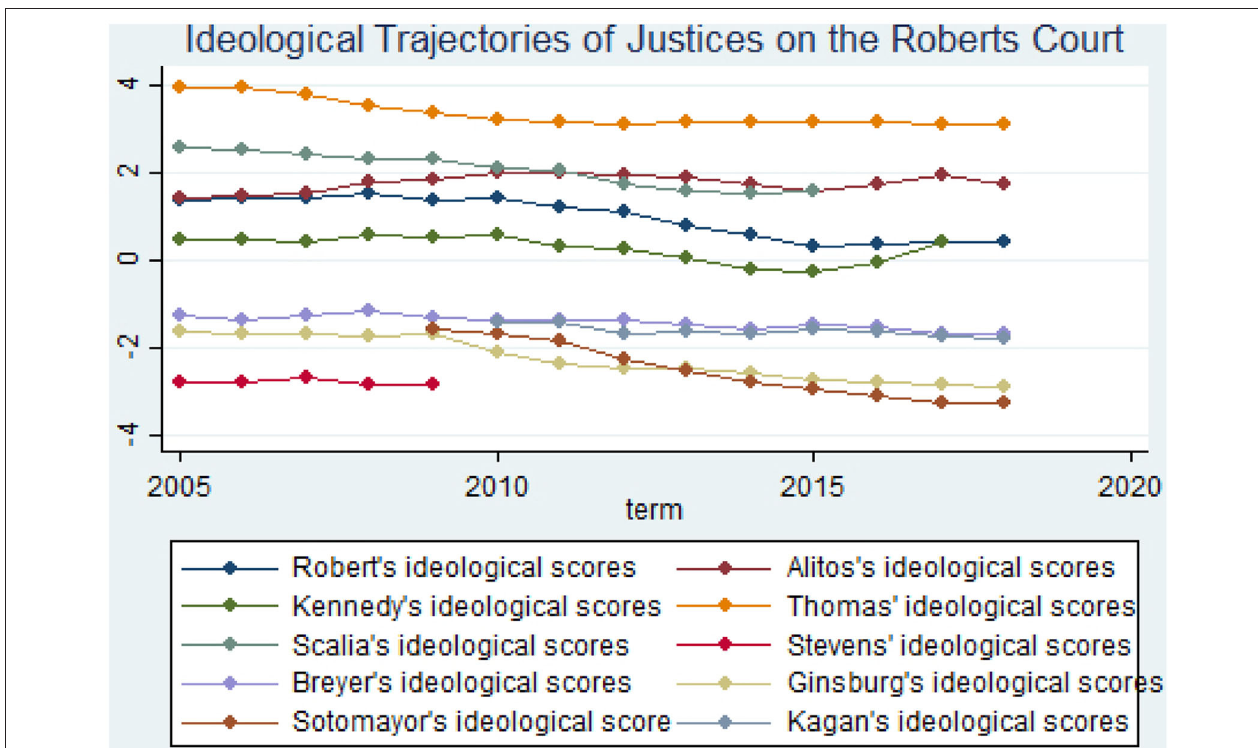
FIGURE 2 | Selected ideological Trajectories of Justices on the Supreme Court. Only trajectories for justices who were on the court for at least five terms are included.